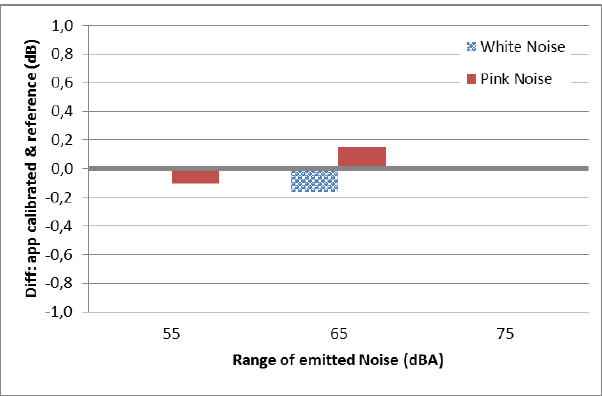
Figure 4: Difference: app calibrated and